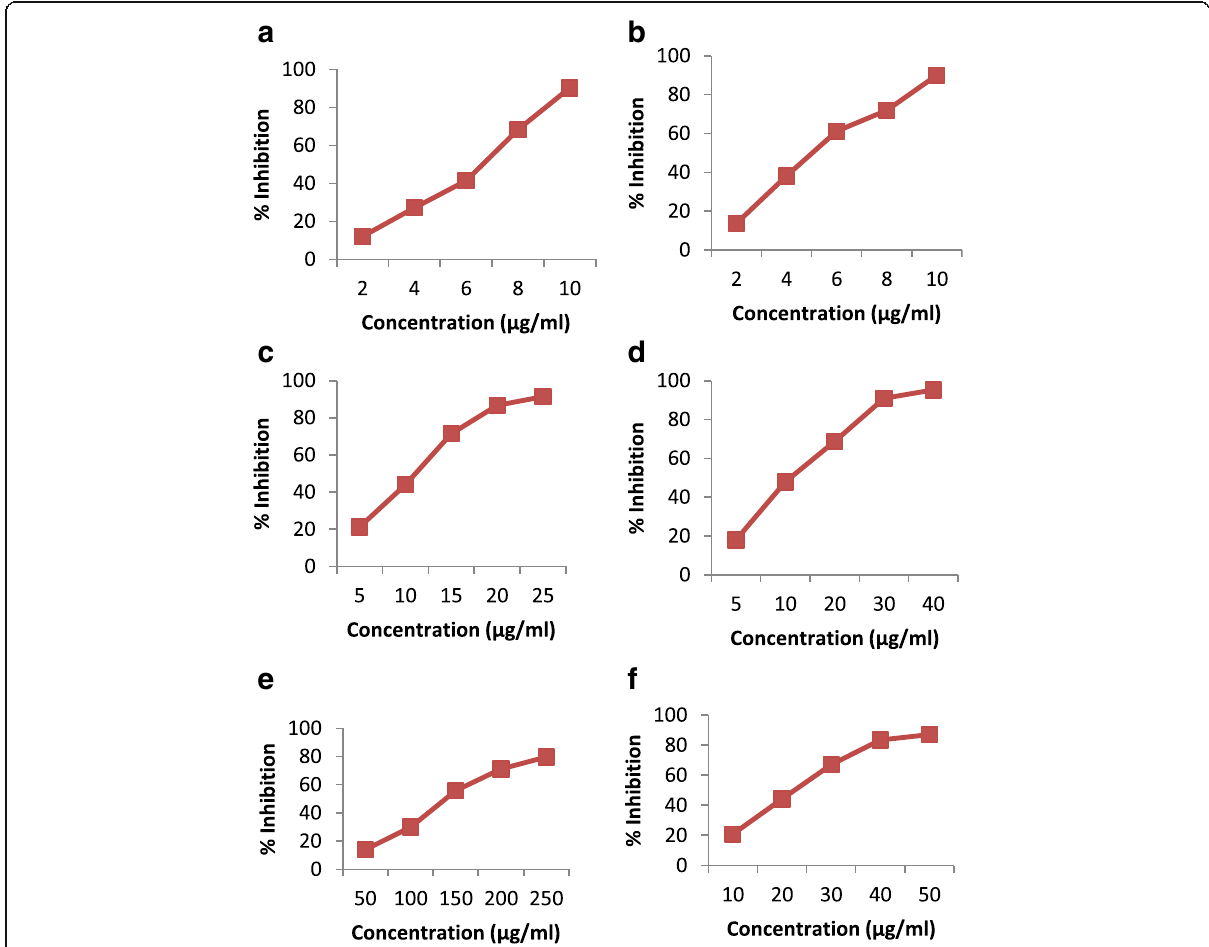
Fig. 2 ABTS free radical scavenging activity of S.caryophyllatum a Ascorbic acid; b Gallic acid; c Bark methanol; d Leaf methanol; e Fruit pulp methanol; f Seed methanol